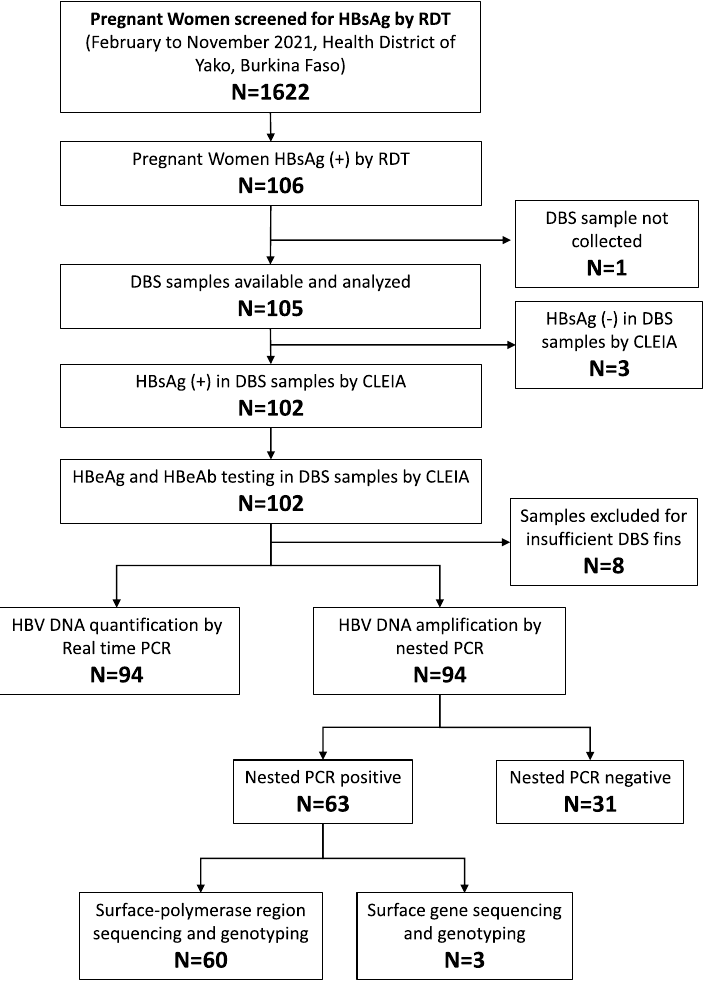
Figure 1. Study and laboratory analysis flow. RDT, Rapid diagnostic test; CLEIA, chemiluminescent enzyme immunoassay; HBsAg, Hepatitis B surface antigen; HBeAg, Hepatitis B e antigen; HBeAb, Hepatitis B e antibody, DBS, Dried Blood